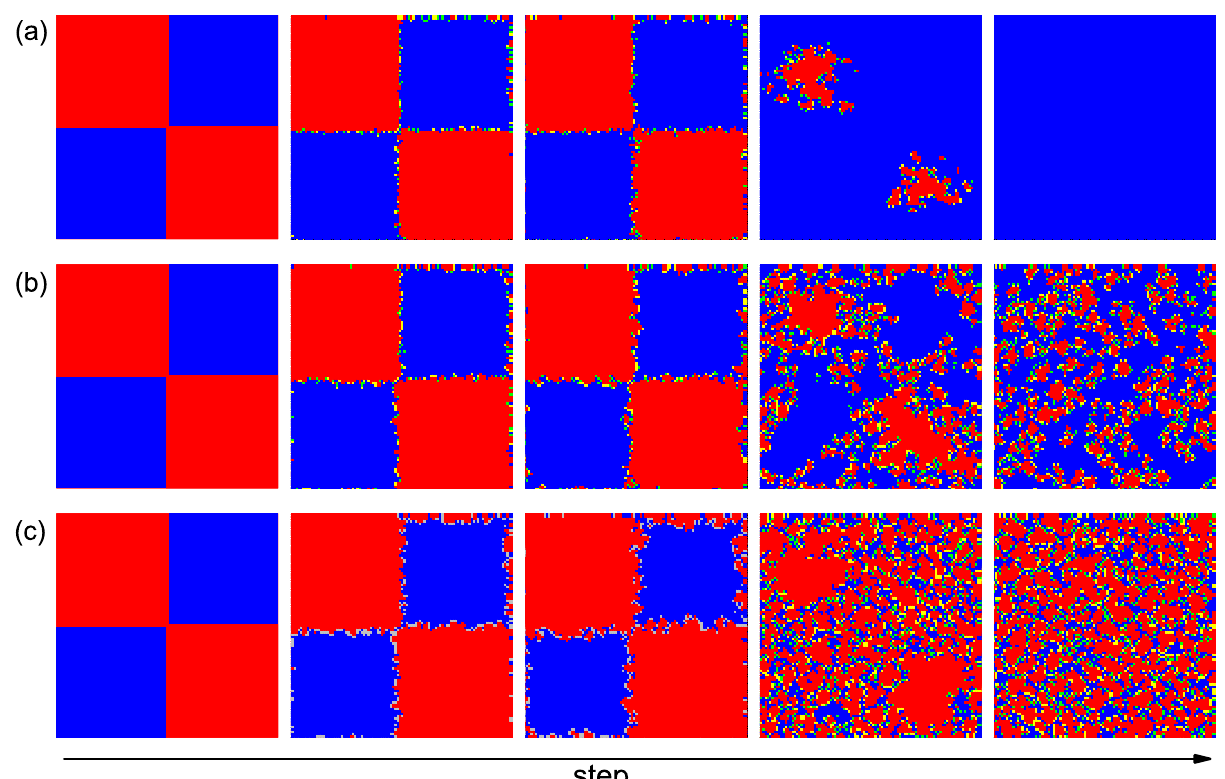
Fig 4. Characteristic snapshots of the distribution of different individuals on square lattices with a prepared initial condition. Red and yellow represent cooperators and blue and green represent defectors. More specifically, yellow denotes a cooperator whose strategy in the last round was defection, while green marks a defector whose strategy in the last round was cooperation. The values of ε are set to be 0 (top row), 0.5 (middle row), 1 (bottom row) and t = 1, t = 10, t = 50, t = 100, t = 10000 from left to right. The game parameter b is fixed to 1.1.